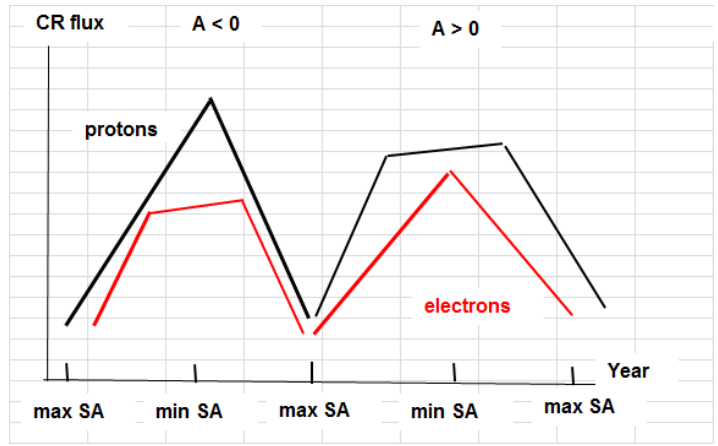
Figure 2. Magnetic fields of the Sun and in the heliosphere during positive ( a ) and negative ( b ) phases of the 22-year solar magnetic cycle. The Sun is depicted as a large circle. In the positive phase ( a ), the solar northern polar field has a positive sign and solar magnetic force lines are pulled from the Sun by the solar wind into the northern part of the heliosphere. In the southern solar polar cup and in the southern part of heliosphere, the magnetic field has a negative sign. In the negative phase ( b ), the directions of the magnetic fields are reversed. The directions of particle drifts in positive phase ( a ) and negative one ( b ) are shown by solid arrows for protons and positrons and dashed arrows for anti-protons and electrons.